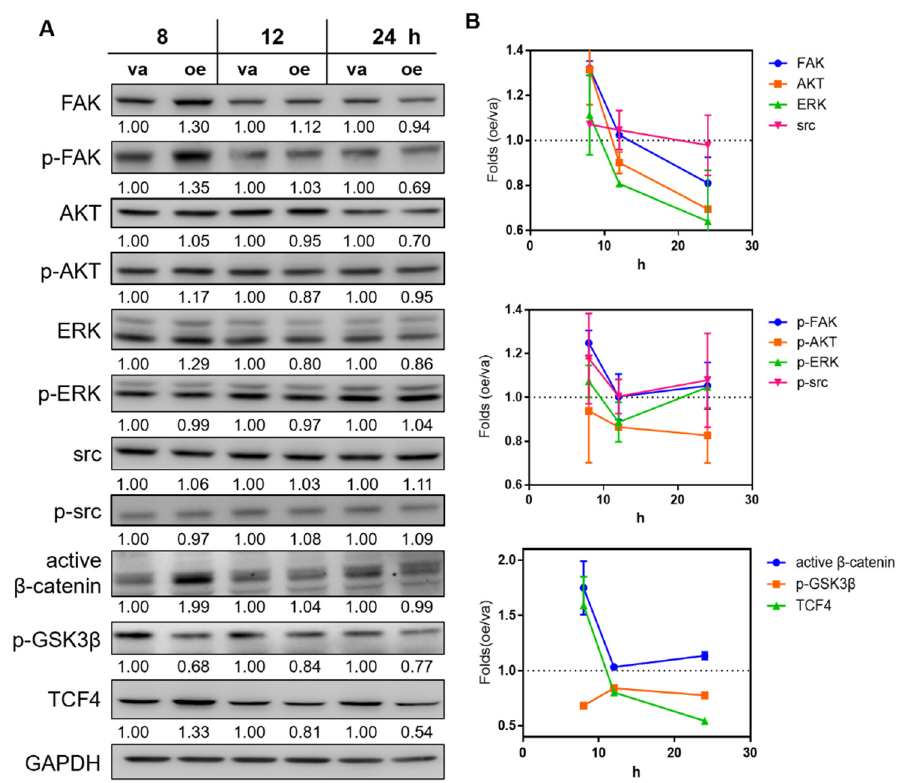
Figure 3. Signal activation after transient MIR31HG expression in SAS cells. ( A ) A representative Western blot analysis showing the expression of various signal factors after transient transfection with the MIR31HG plasmid for 8, 12, and 24 h. The numbers are normalized values. ( B ) The changes of signal protein levels over the time course following transfection. Upper, FAK, AKT, ERK, and src; Middle, p-FAK, p-AKT, p-ERK, and p-src; Lower, active β -catenin, p-GSK3 β and TCF4. va, vector alone; oe, transient MIR31HG overexpression.